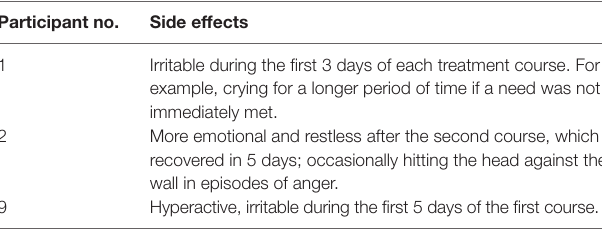
TABLE 2 | Side effects reported by caregivers during and after high-frequency repetitive transcranial magnetic stimulation (HF-rTMS) treatment courses. Participant